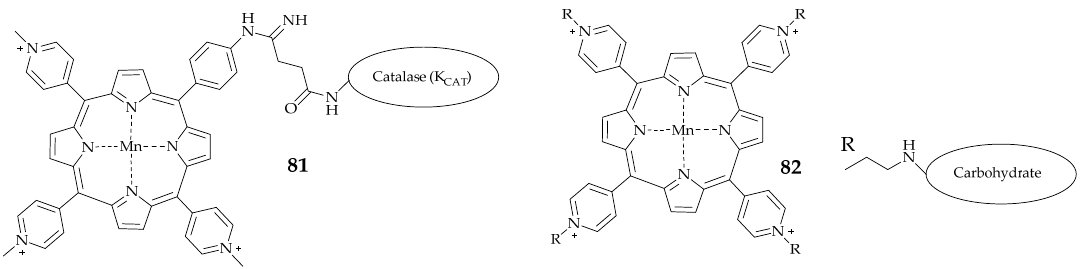
Figure 13. Structures of Mn-porphyrin (MnP) conjugates 81 , 82 .